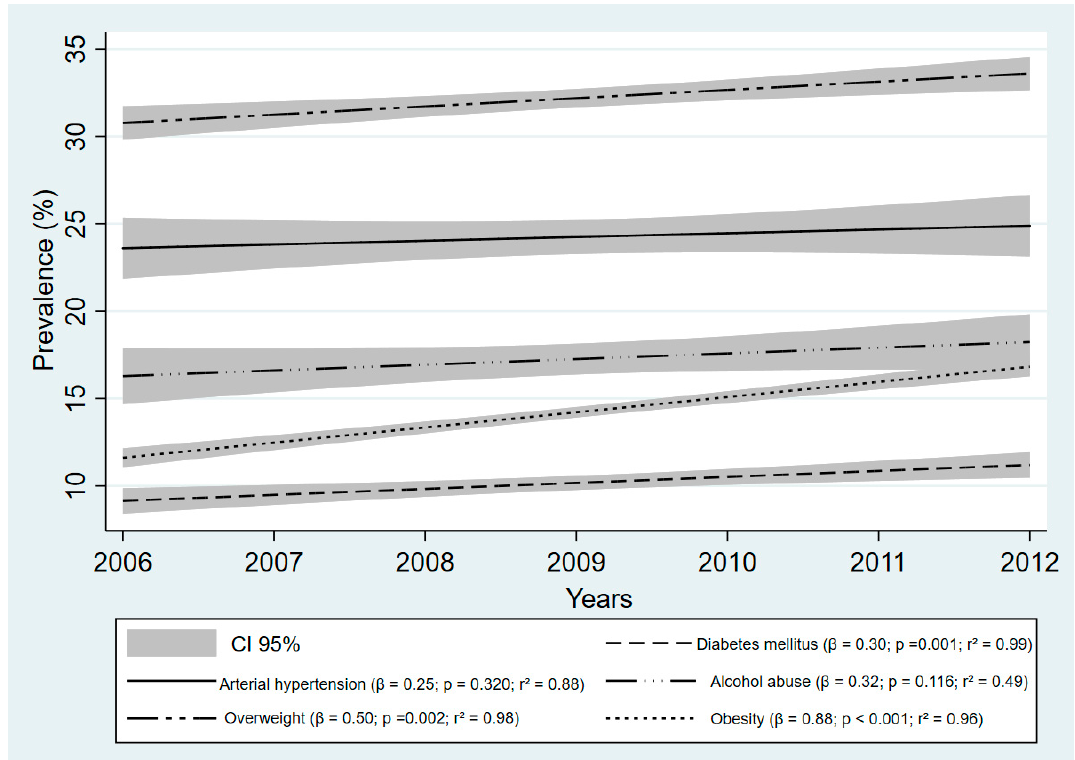
Figure 1. Prevalence of major modifiable risk factors of stroke among Brazilian adults between 2006 and 2012. Data Source: Surveillance of Risk Factors and Protection for Chronic Diseases by Telephone Inquiry